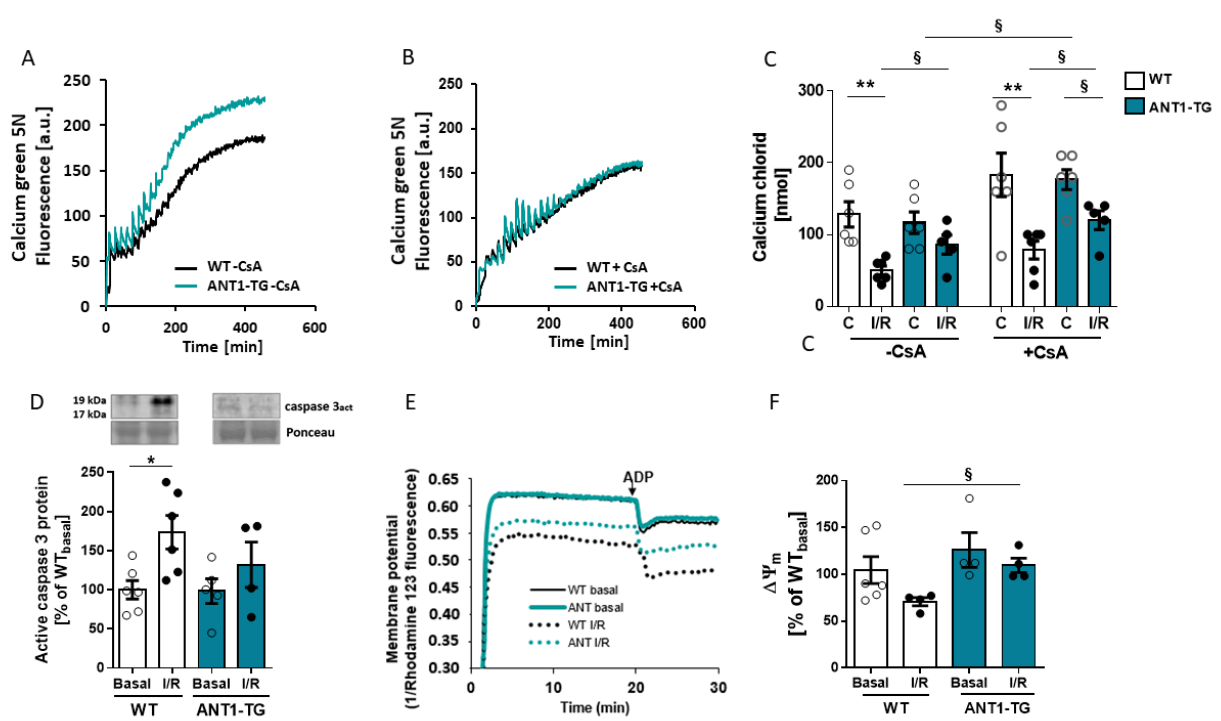
Figure 2. Calcium handling and membrane potential of cardiac mitochondria. Mitochondria were isolated from WT and ANT1-TG hearts after 15 min of basal perfusion (Basal) or after 45 min of ischemia, followed by two hours of reperfusion (I/R). Calcium retention capacities were measured in glutamate/malate buffer by adding 10 nmol CaCl 2 to the mitochon- dria, in the presence or absence of cyclosporin A (CsA), every three minutes until the pore opened. Representative time courses are shown for WT and ANT1-TG mitochondria in the absence ( A , B ) presence of cyclosporin A. ( C ) The quantifi- cation of the calcium retention capacities for WT and ANT1-TG mitochondria, before and after I/R. ( D ) Quantitative anal- ysis of active caspase 3 protein expression was performed by Western blot analysis. The upper panel shows representative Western blots, with Ponceau staining as the internal control. ( E ) The membrane potential was measured using rhodamine 123, and the differences in fluorescence emissions 1 min before and 1 min after the addition of ADP were measured. Increased dye emissions represent decreased membrane potential. ( F ) Quantification of the mitochondrial membrane po- tential (ΔΨ m ). Data are presented as the mean ± SEM * p < 0.05, ** p < 0.01 using the Kruskal – Wallis test; or § p < 0.05 calculated with the Mann – Whitney U test. 3.3. ANT1 Overexpression Stabilizes Mitochondrial Oxygen Consumption after I/R Oxygen consumption by WT and ANT1-TG mitochondria were measured using complex I (glutamate/malate) and complex II substrates (succinate) (Figure 3). Mitochon- dria isolated from reperfused WT hearts showed reduced oxygen consumption compared to mitochondria without I/R treatment in the presence of the complex I substrate and the absence of ADP, whereas respiration in ANT1-TG mitochondria from reperfused hearts did not change (Figure 3A). In the presence of the complex II substrate without ADP, ANT1-TG showed again no reduction in respiration, and the oxygen consumption of WT mitochondria did not significantly decrease (Figure 1B). ADP-stimulated respiration (state 3) declined in WT mitochondria in the presence of the complex I substrate after I/R relative to mitochondria without I/R treatment. In contrast, no significant difference in ADP-stim- ulated respiration was observed in ANT1-TG mitochondria after I/R compared to mito- chondria without I/R treatment when using the complex I substrate (Figure 3C). Similarly,